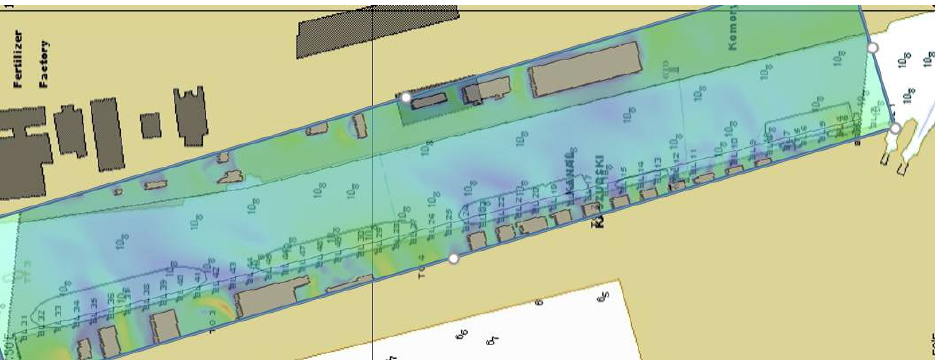
Figure 18. The process of creating a weather zone.